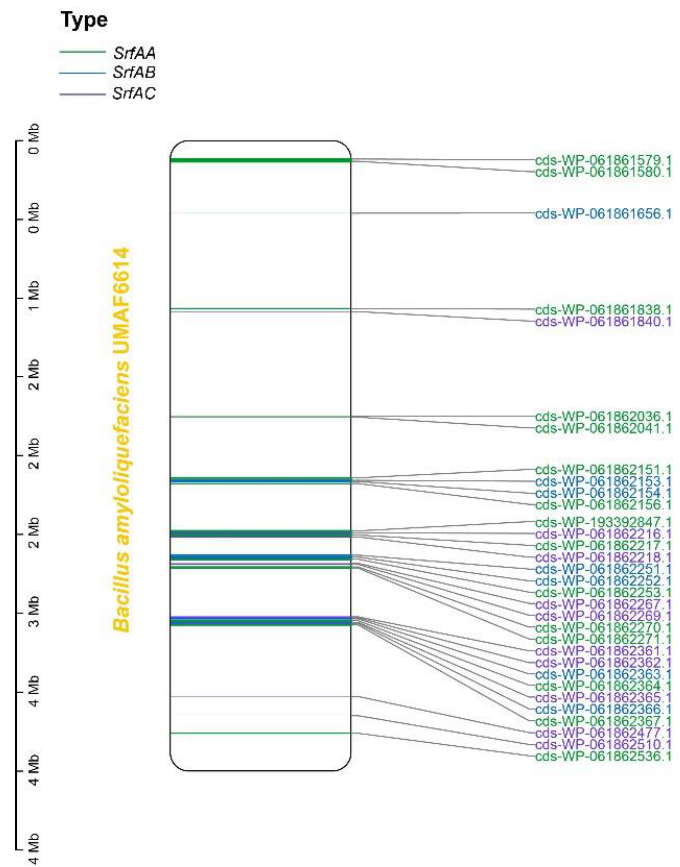
Figure 2. Distribution of SrfAA , SrfAB and SrfAC genes in Bacillus amyloliquefacieus UMAF6614 (GCF_001593785) genome.